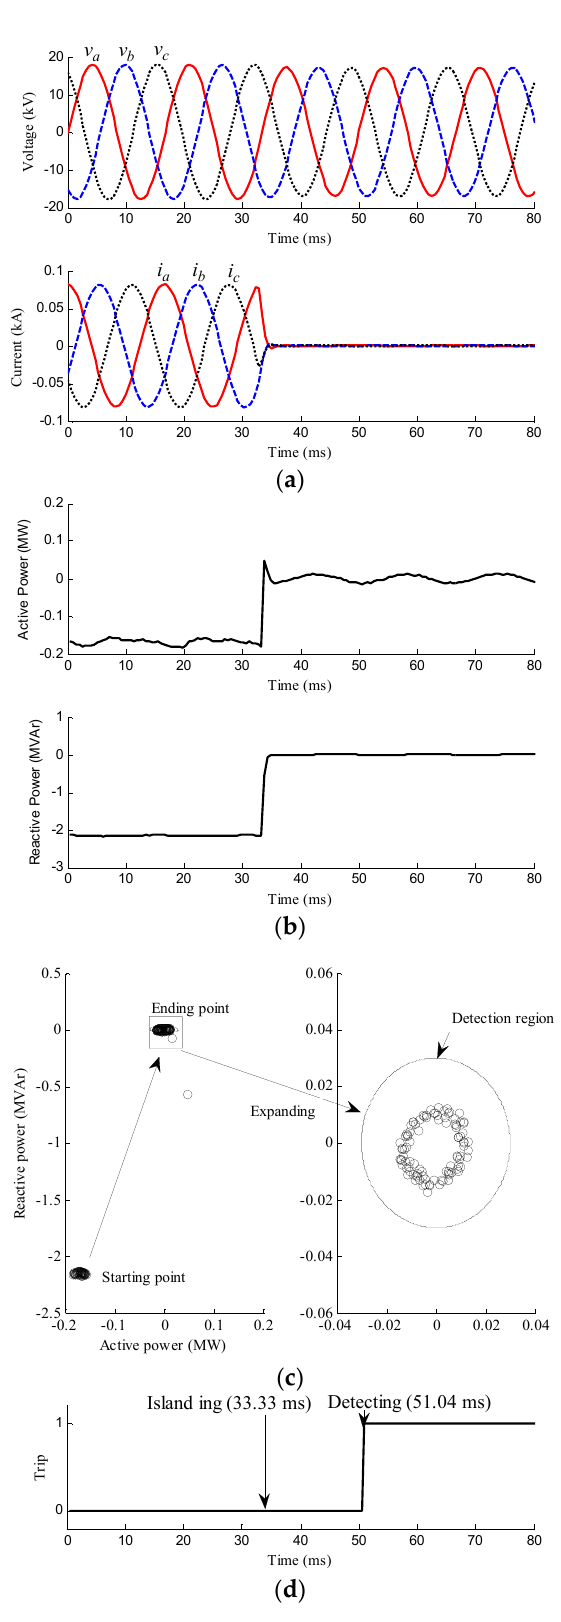
Figure 16. Hardware implementation results for Case 1. ( a ) v a , b , c (upper) and i a , b , c (lower); ( b ) p 3 ph (upper) and q 3 ph (lower); ( c ) Trajectories of the point ( p 3 ph , q 3 ph ); ( d ) Islanding detection signal.